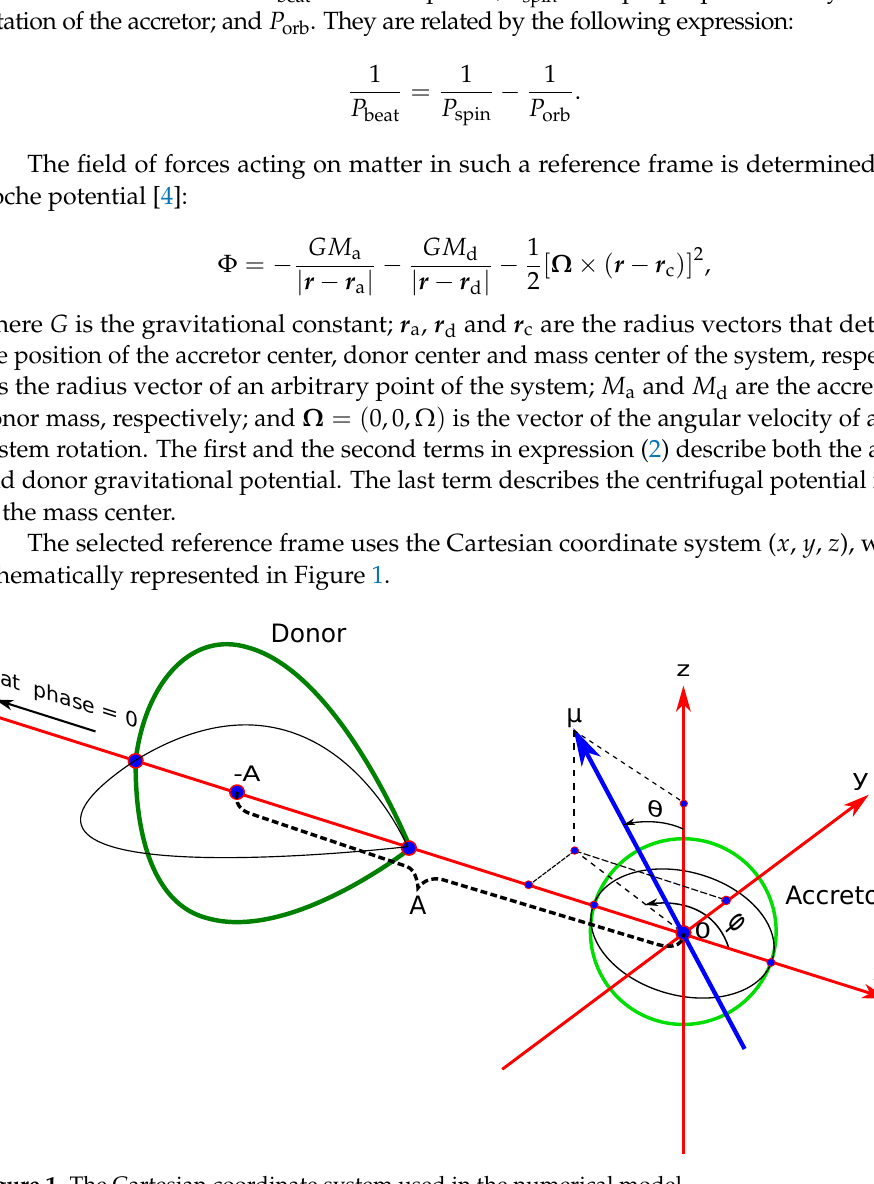
Figure 1. The Cartesian coordinate system used in the numerical